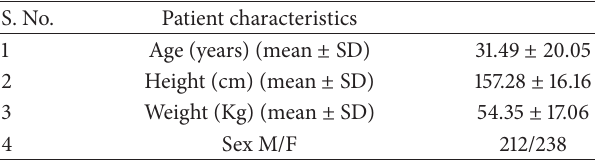
Figure 2: Quality of transmitted ECG. Table 2: Individual characteristics.